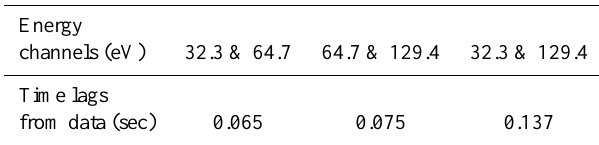
Table 1. Time lags from FAST data (top row) calculated from the electron flux downward energy channels centred at 32.3eV,